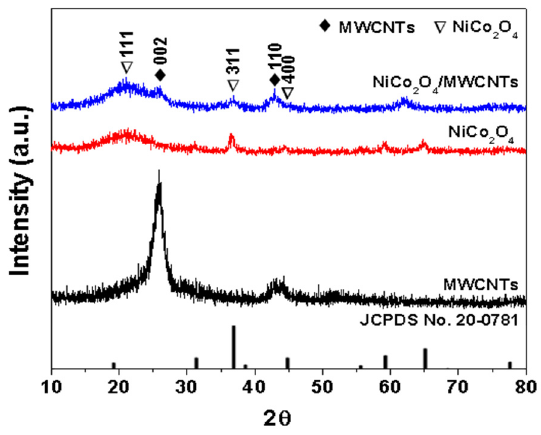
Figure 1. XRD test results of MWCNTs, NiCo 2 O 4 , and NiCo 2 O 4 /MWCNTs.